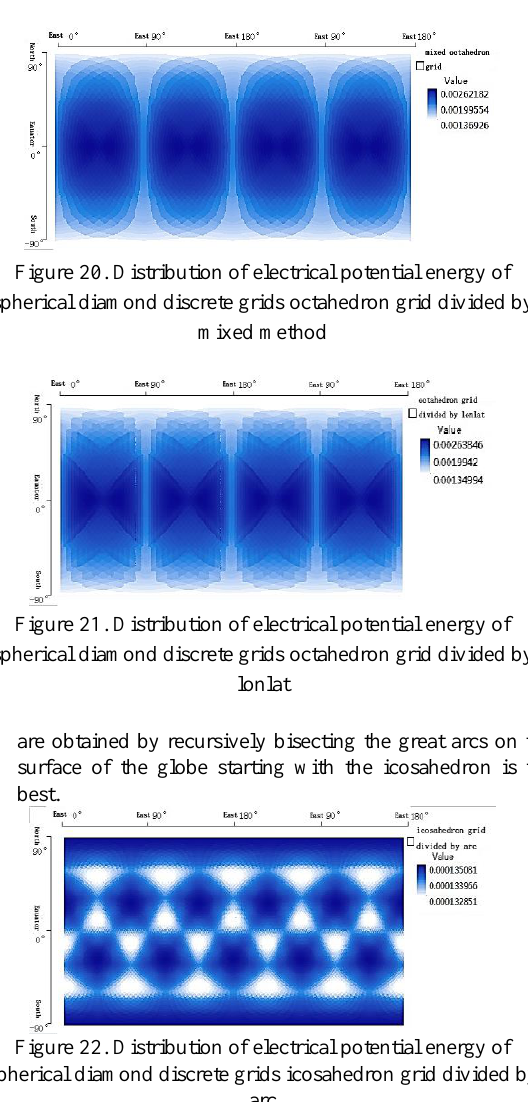
Figure 19. Distribution of electrical potential energy of spherical diamond discrete grids octahedron grid divided by arc